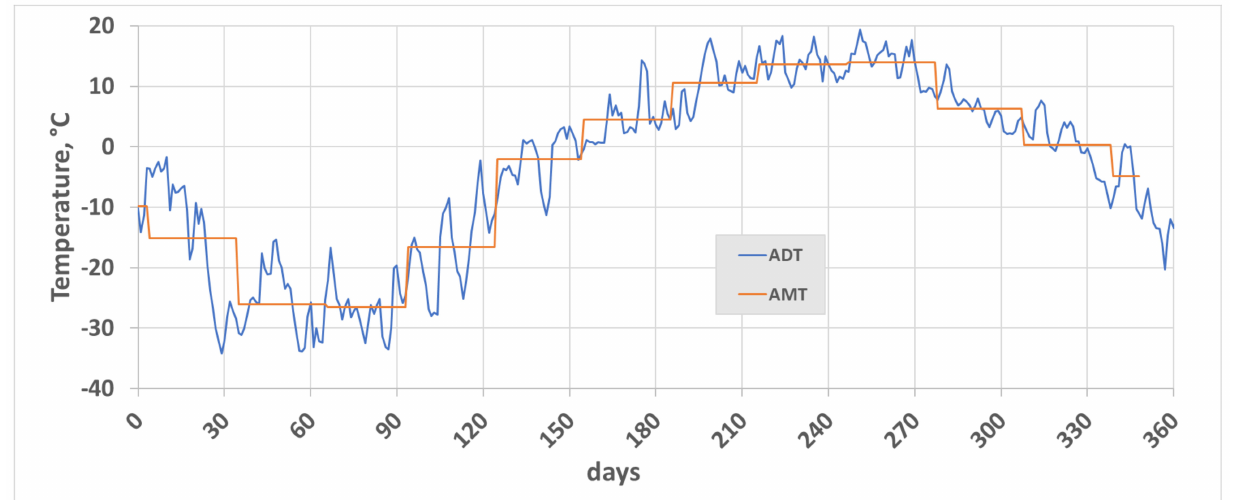
Figure 15. Average daily temperature (ADT) and average monthly temperatures (AMT) during the observation period.